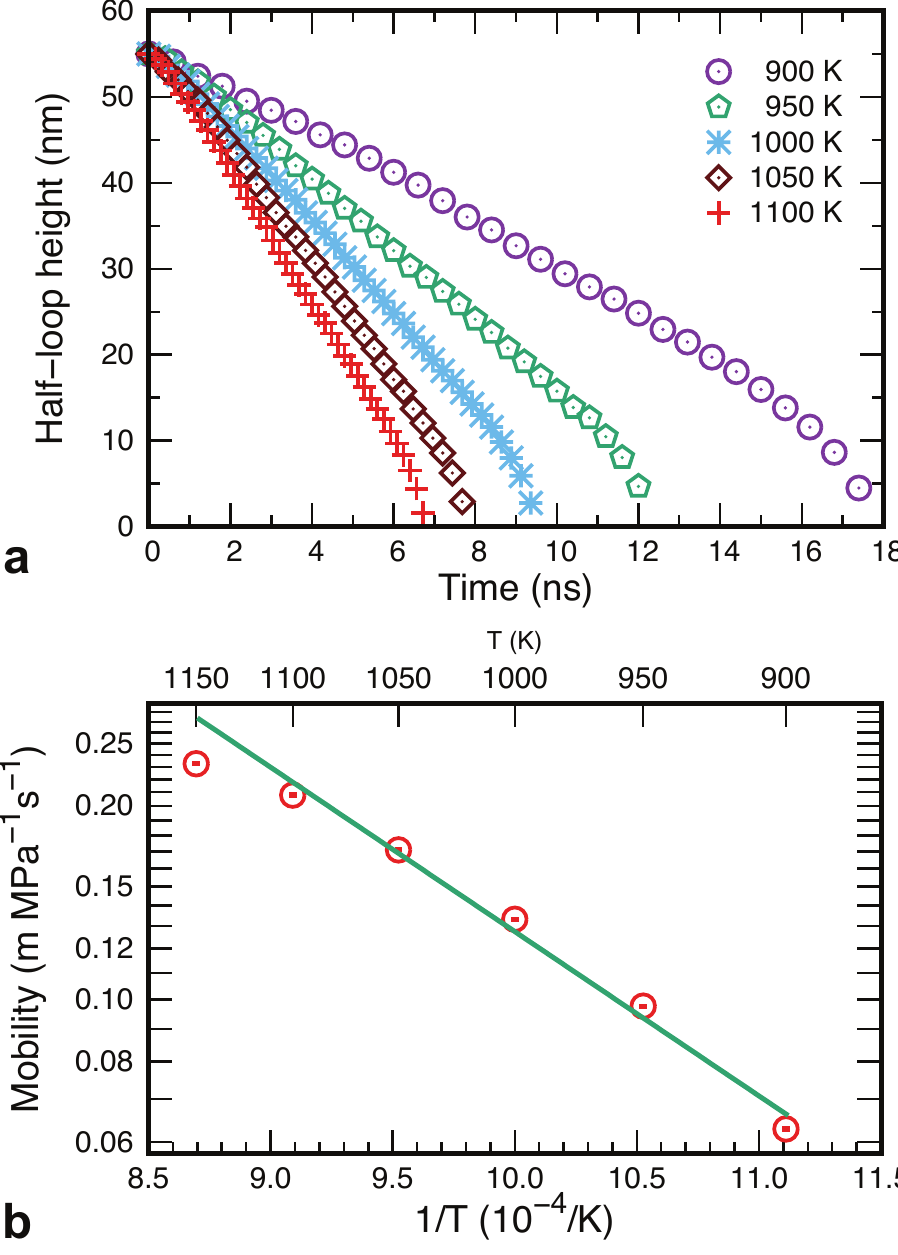
Figure 3. GB dynamics in MD simulations of pure Cu. ( a ) The grain height as a function of time at several temperatures. ( b ) Arrhenius diagram of GB mobility. The points in ( b ) correspond to the temperatures indicated in ( a ), with the straight line representing the linear fit to determine the effective activation energy as GB